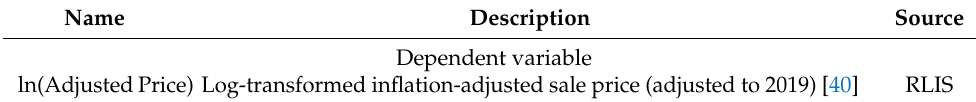
Table 1. Description of variables used in this study.